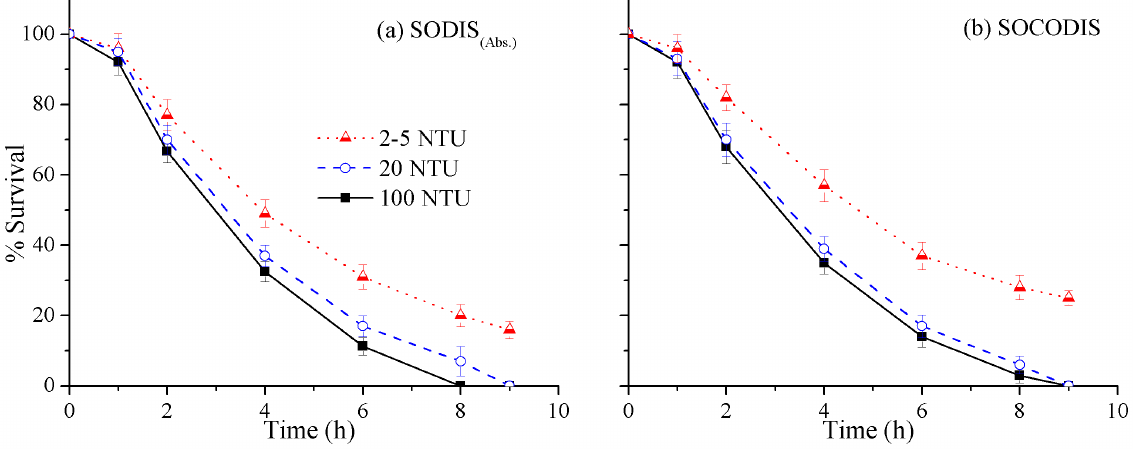
Figure 9. Effects of different turbidity values on P.aeruginosa inactivation in (a) SODIS (Abs.) (sunny weather), and (b) SOCODIS system (mild weather).